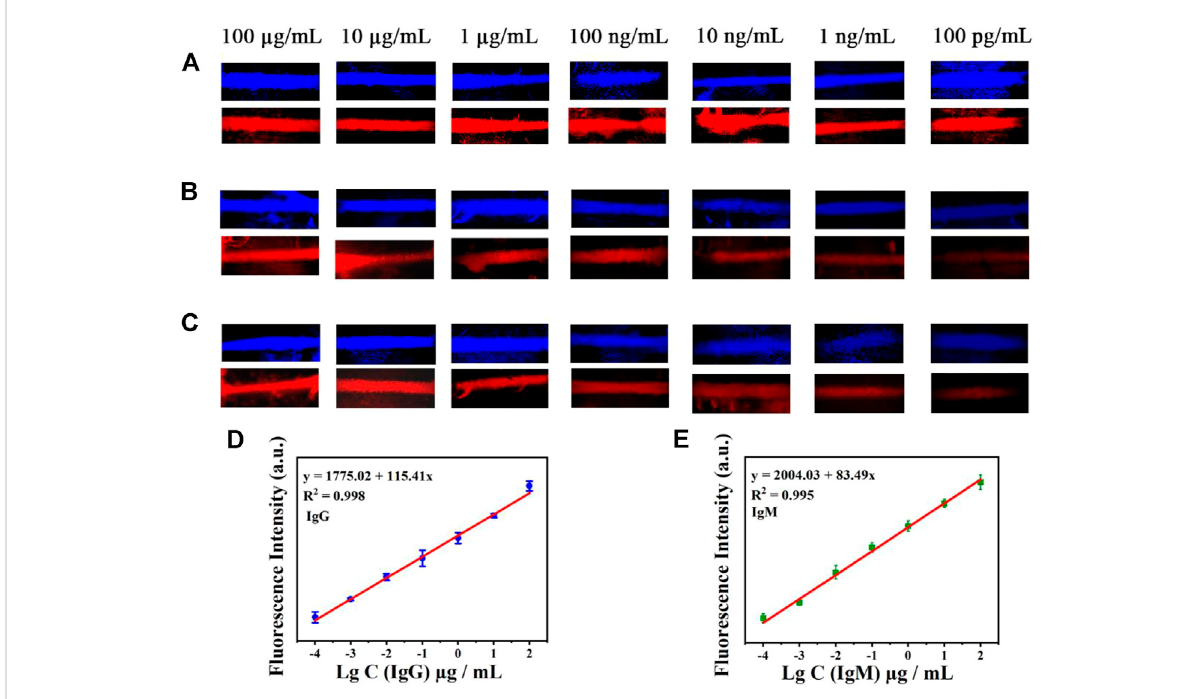
FIGURE 4 Test strip ’ s simultaneous detection of IgM and IgG antibodies by AIE-CD-SSP under the fl uorescence microscope of blue light irradiation and green light irradiation. (A) C-line, (B) antibody IgM, and (C) antibody IgG (concentrations from top to bottom are 100 μ g/ml, 10 μ g/ml, 1 μ g/ml, 100 ng/ml,10 ng/ml,1 ng/ml,and100 pg/ml);therelationship betweenthedetected fl uorescenceintensityof591 nmandconcentrationunderthe excitation wavelength at 500 nm of IgG (D) and IgM (E) .